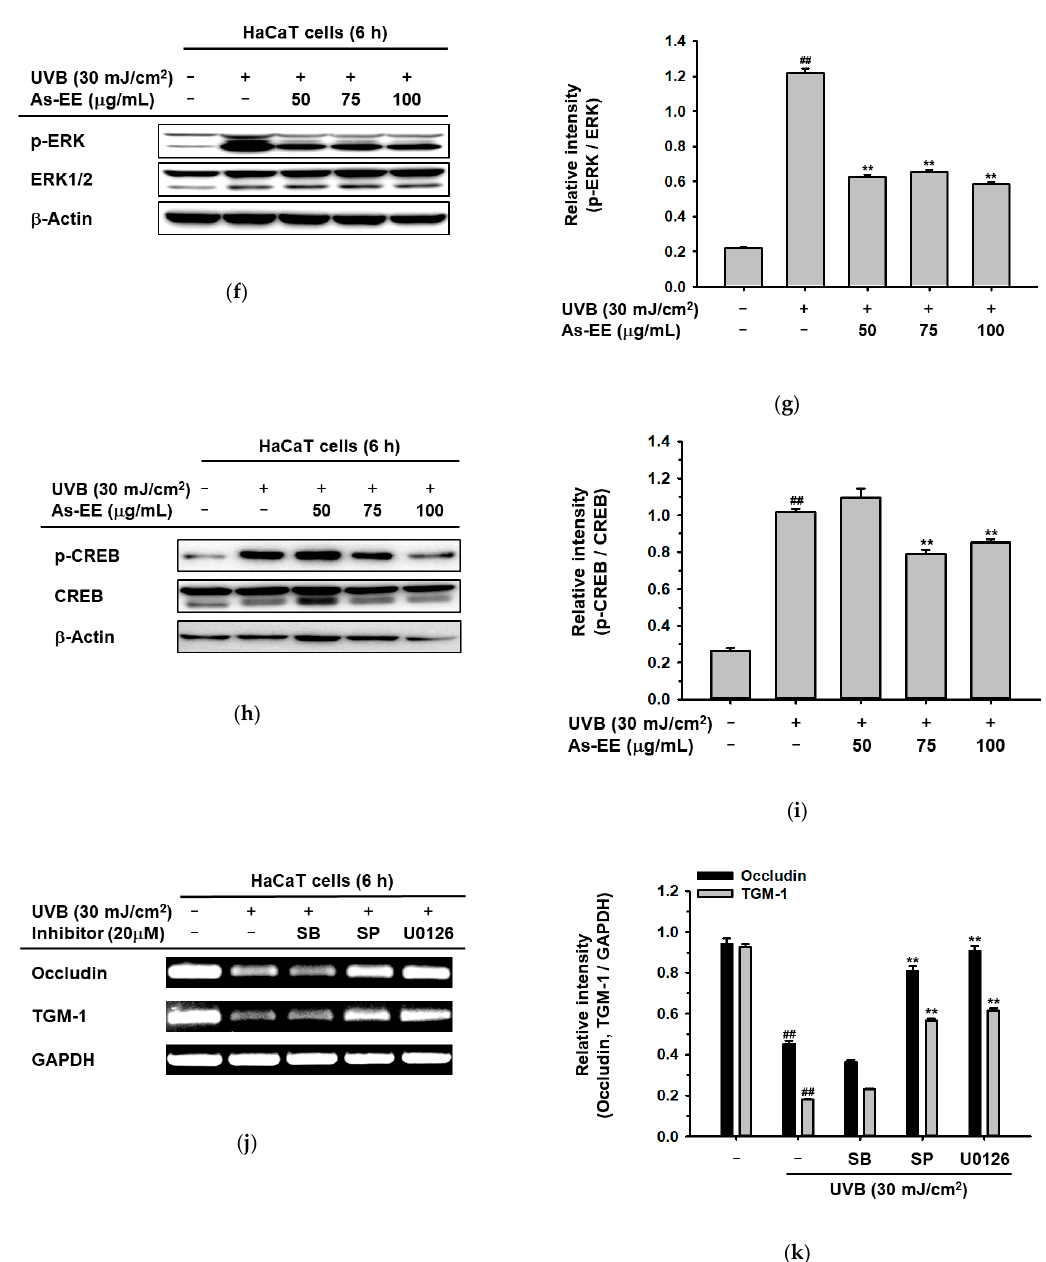
Figure 4. Moisturizing and anti-apoptotic effect of As-EE in UVB-irradiated human keratinocytes. ( a ) The morphology of HaCaT cells with As-EE treatment (50 and 100 µg/mL) under UVB irradiation for 6 and 12 h was examined using microscopy; ( b ) Viability of HaCaT cells was evaluated with an MTT assay in As-EE-treated cells exposed to UVB irradiation; ( c ) FACS analysis in HaCaT cells treated with As-EE under UVB irradiation; ( d ) HaCaT cells were pre-treated with As-EE for 30 min and irradiated with UVB. After incubation for 6 h, the mRNA levels were measured with RT-PCR; ( e ) The relative intensity of mRNA was measured with ImageJ; ( f ) Phosphorylation levels of ERK were checked with an immunoblot analysis; ( g ) The relative intensity of protein was measured using ImageJ; ( h ) Phosphorylation levels of CREB were checked with an immunoblot analysis; ( i ) The relative intensity of protein was measured using ImageJ; ( j ) HaCaT cells were treated with MAPK inhibitors (SB20580, a p38 inhibitor; SP600125, a JNK inhibitor; and U0126, an ERK inhibitor) for 6 h under UVB irradiation and mRNA levels were determined with RT-PCR; ( k ) The relative intensity of mRNA levels was measured with ImageJ. * p < 0.05 and ** p < 0.01 compared with the control groups (only UVB group). # p < 0.05 and ## p < 0.01 compared with the normal groups.